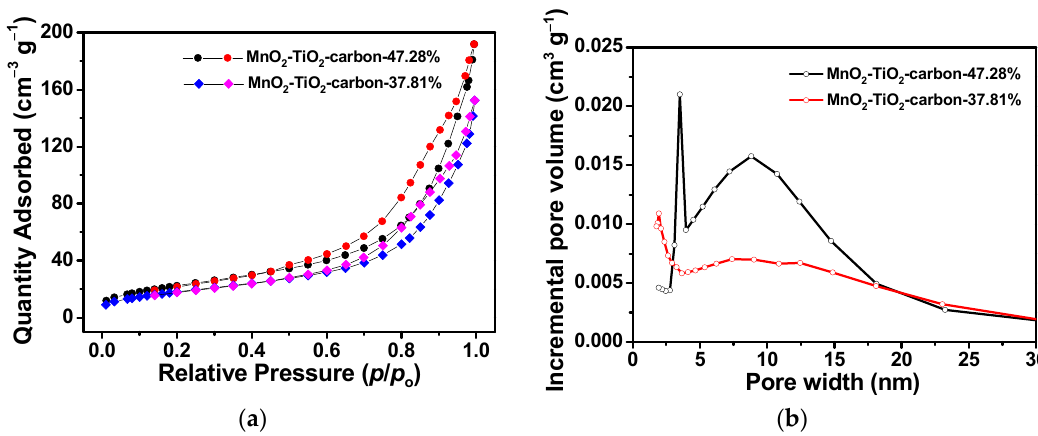
Figure 6. ( a ) Nitrogen adsorption–desorption isotherms and the ( b ) pore-size distribution curves of the MnO 2 -TiO 2 -carbon-47.28% and MnO 2 -TiO 2 -carbon-37.81% composites.